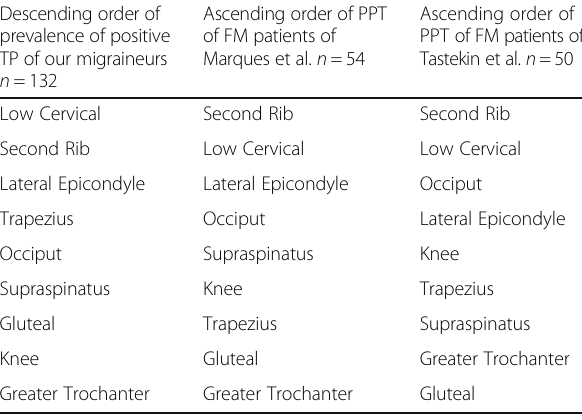
Table 6 Comparison between sites sorted in descending order of prevalence of positive TP of our migraineurs and sites arranged in descending order of PPT of FM patients in previous studies Descending order of prevalence of positive TP of our migraineurs n